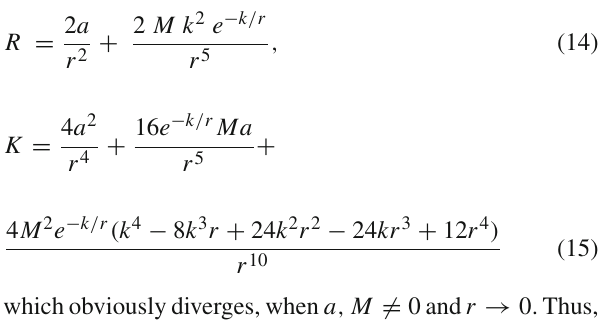
Fig. 1 The parameter space ( a , ˜ k ) for the existence of black holes. The black solid line corresponds to the extremal black holes